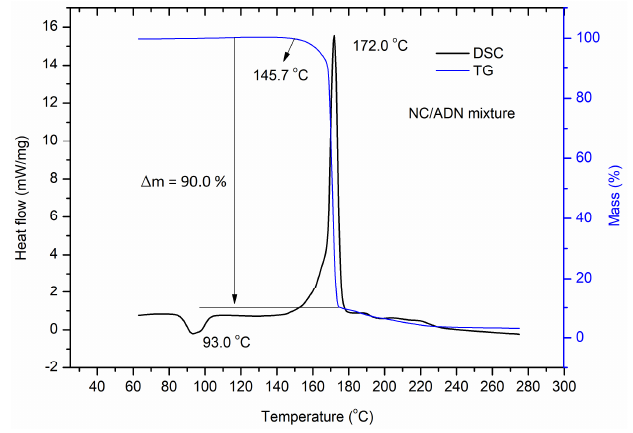
Figure 1. DSC-TG curves of ADN, NC and NC/ADN mixture in open circumstances.